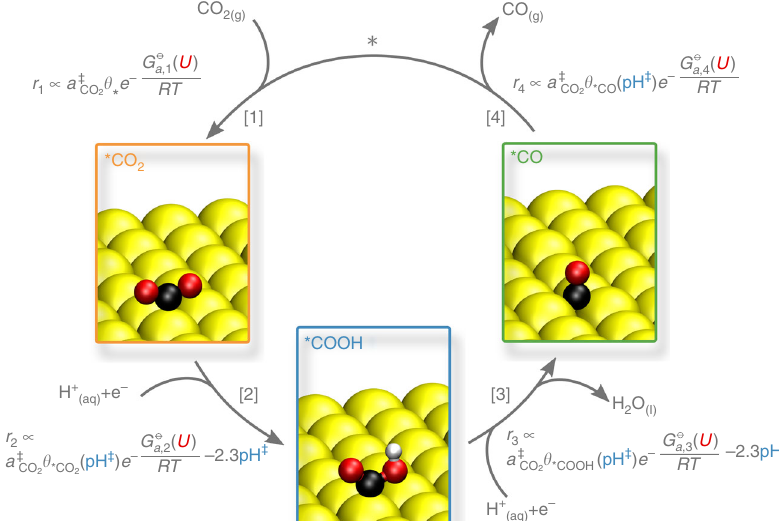
Fig. 1 Considered reaction mechanism for CO 2 R on Gold. The gray equations depict the measurable CO production rate r k in the case that the corresponding reaction step k is limiting the overall conversion process, a z i and pH z depicts species activities and pH at the reaction plane. All equations are given for acidic reaction conditions on an absolute potential reference scale. The coverage of empty sites ( θ (cid:2) ) is roughly pH independent, since it is always close to one on